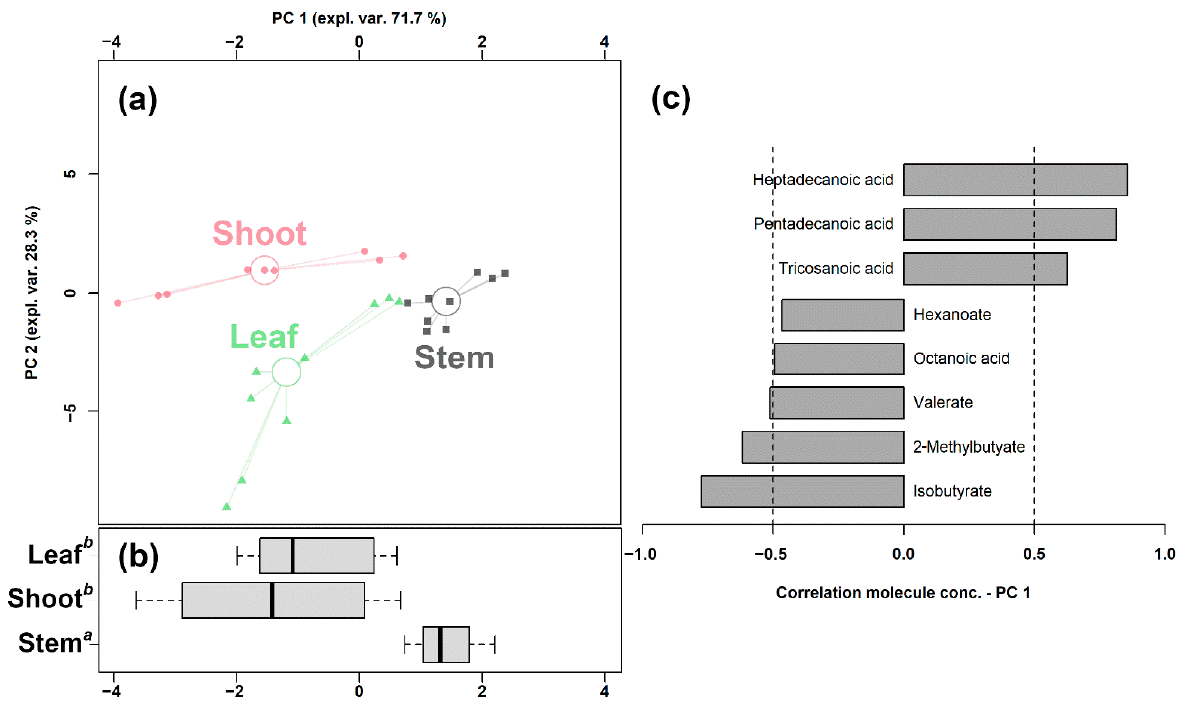
Figure 1. rPCA model built on the concentration of the fatty acids that showed a statistically significant difference among shoots, leaves, and stems. In the scoreplot ( a ), samples from the three groups are represented with circles, triangles, and squares, respectively. The wide, empty circles represent the median of the samples of various samples. The position of the samples along PC 1 is summarized in boxplot ( b ). The loading plot ( c ) reports the correlation between the concentration of each substance and its importance over PC 1.